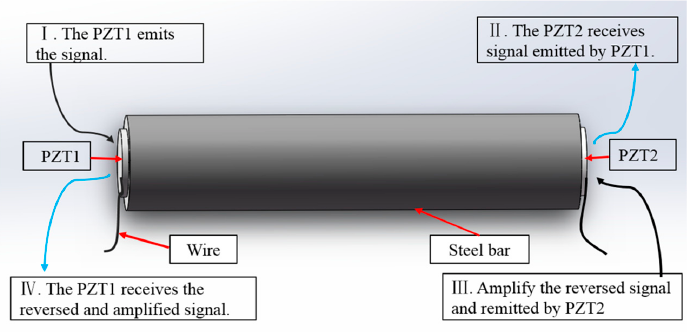
Figure 2. Time reversal process of steel bar corrosion monitoring.